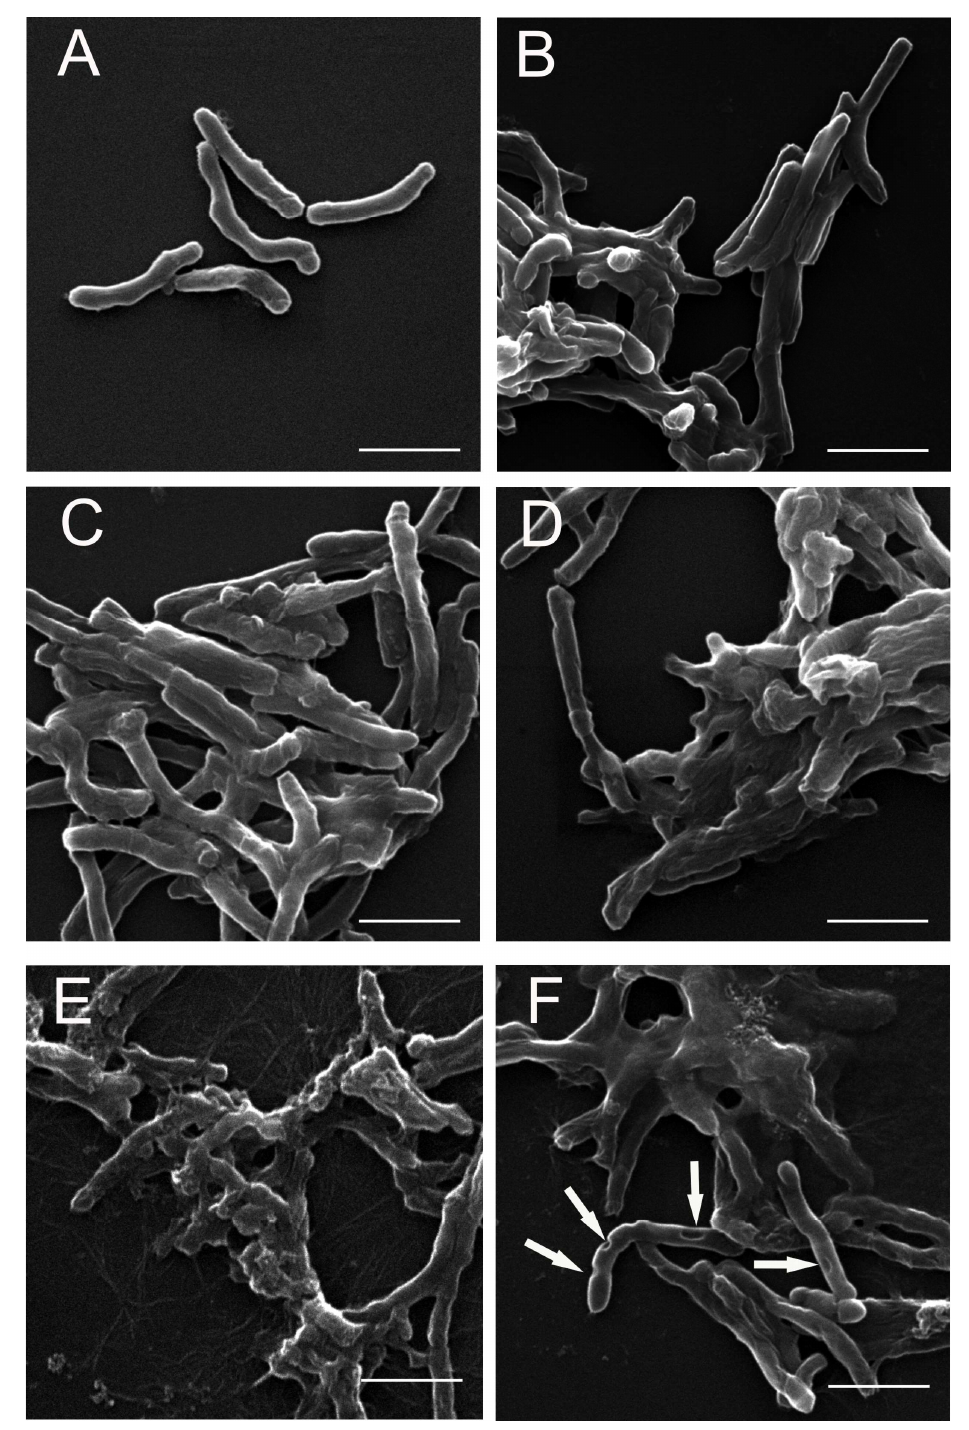
Figure 5. SEM microphotographs of M. smegmatis control cells and cells incubated with the S. hermaphrodita protein seed extract (PSE) for 6 days: ( A )— M. smegmatis control culture cells; ( B )— M. smegmatis cells after treatment with PSE at a concentration of 25 µg/mL; ( C )—50 µg/mL; ( D )—75 µg/mL, ( E )—100 µg/mL; ( F )—150 µg/mL. The surface of the extract-treated cells showed significant deformations and cavities. The arrows indicate defects in the continuity of the cell wall. The scale bar corresponds to 2 µm.